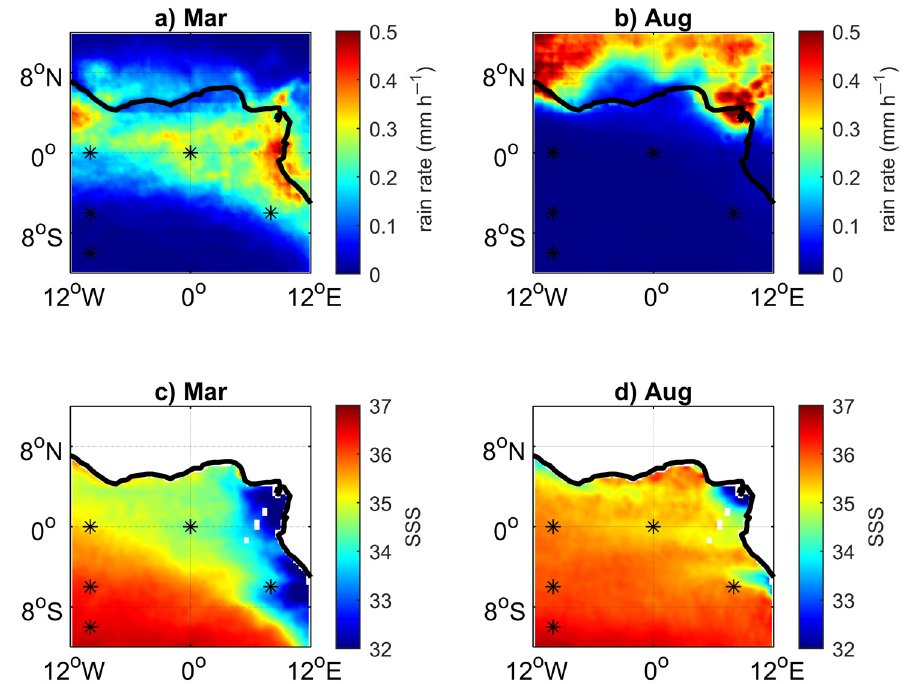
Figure 3. Distribution of the Tropical Rainfall Measuring Mission (TRMM) rain rate for ( a ) March and ( b ) August and Soil Moisture and Ocean Salinity Satellite (SMOS) SSS for ( c ) March and ( d ) August DIC. The PIRATA moorings are indicated by the black stars ( (cid:31) ).